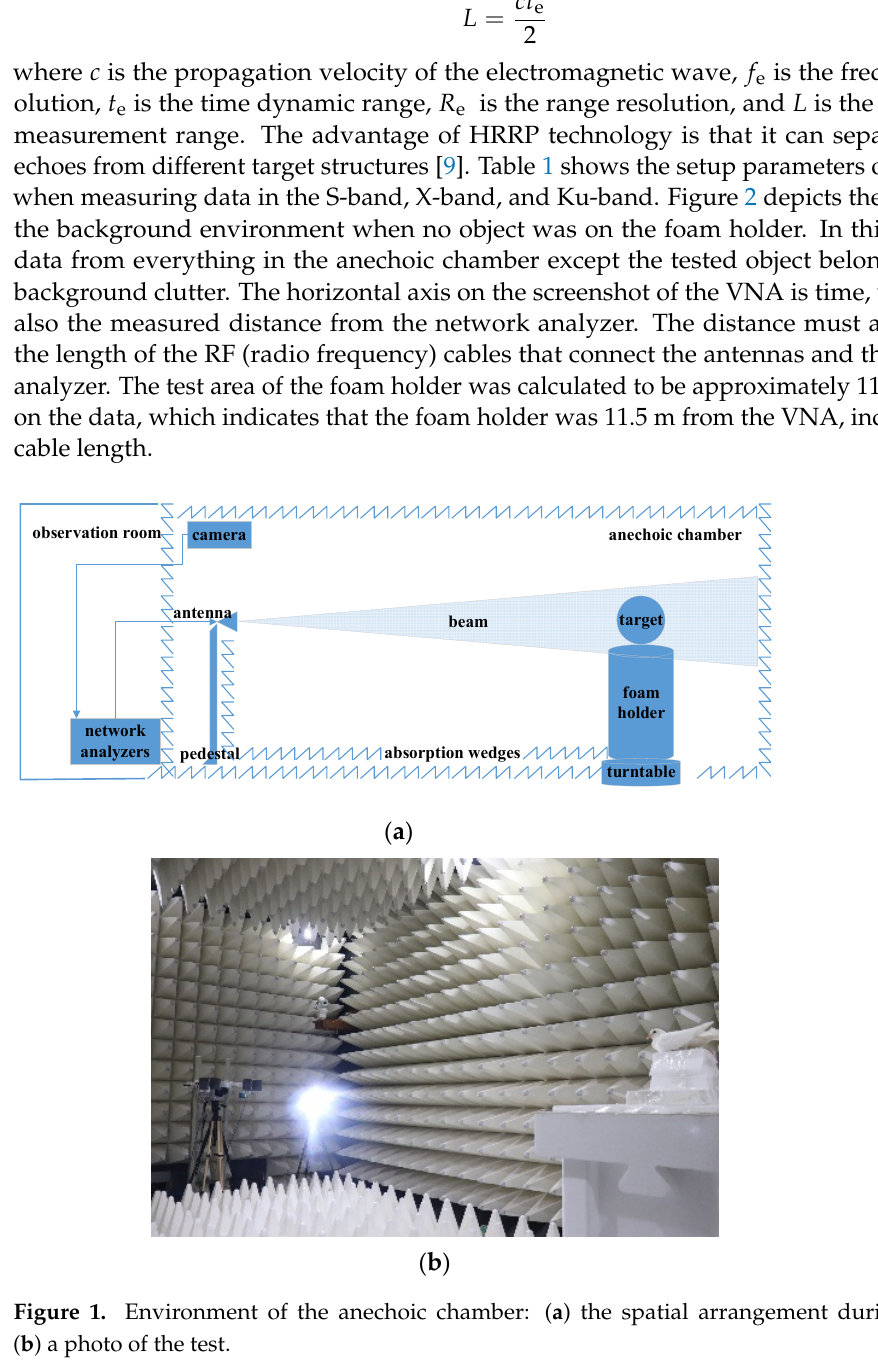
( a ) ( b ) Figure 2. Example from the background environment: ( a ) data of the background, ( b ) a photo of no object on the foam holder, and an image of a large sphere on the foam holder. Table 1. Parameters of the network analyzer. Content